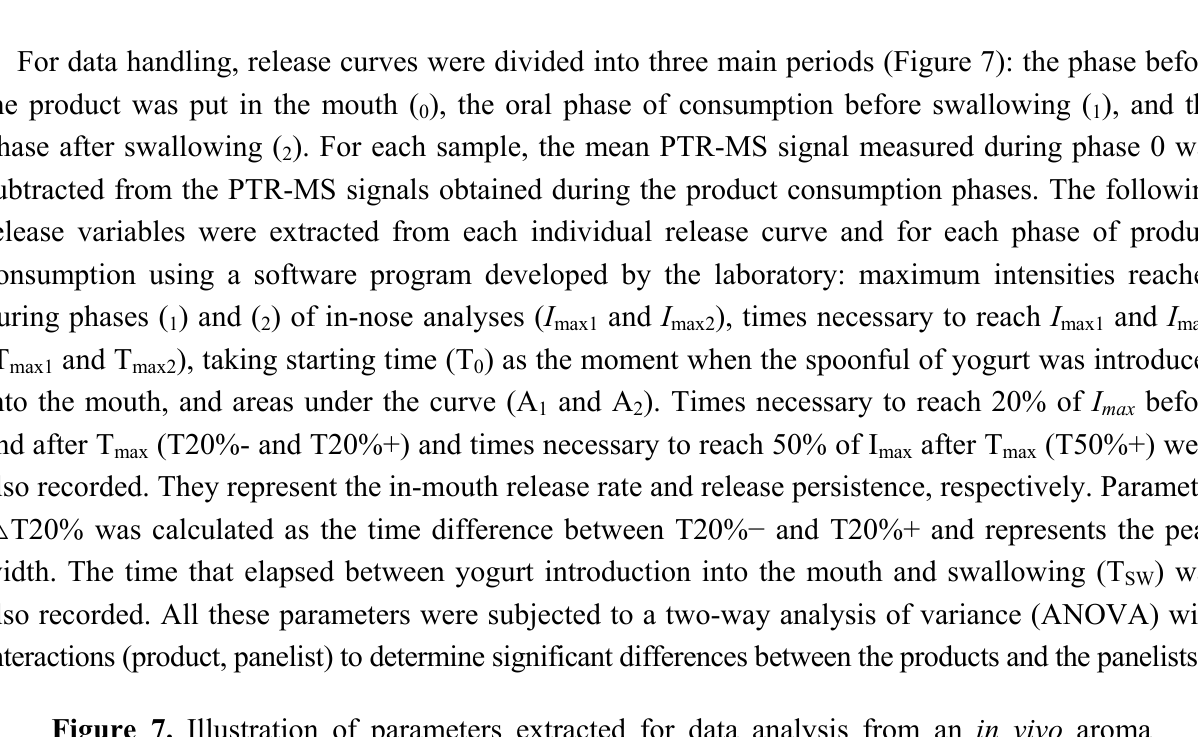
Figure 7. Illustration of parameters extracted for data analysis from an in vivo aroma release, obtained for P_Standard yogurt eaten by panelist number 3 (first repetition) and ion m/z 61 by PTR-MS measurement. Phases 1 and 2 refer to periods before and after